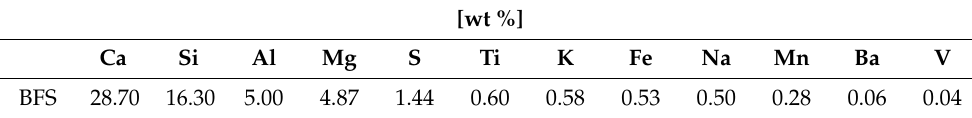
Table 5. Elemental composition of the blast furnace slag as determined by ICP-OES analysis 1 .